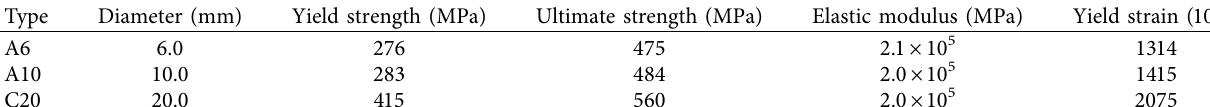
Figure 5: Reinforcement drawing. (a) Column. (b) Beam. (c) Cast-in-place belt. Table 4: Strength of steel bar.